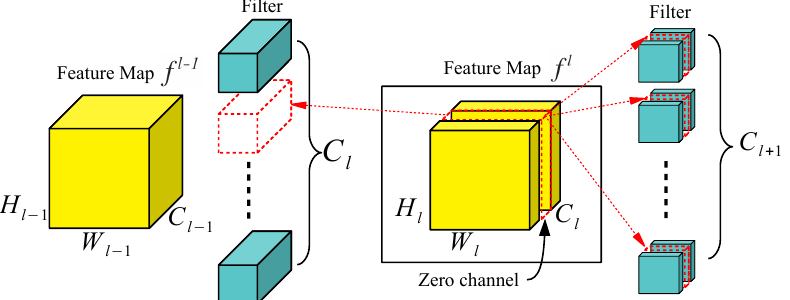
Figure 1. Removing filters based on the zero-response channel in the feature map: by removing the zero-response channel of the feature map f l , it is possible to reduce the filters of the encoder convolution layer that generates the zero-response and the filters of the decoder convolution layer that takes the zero-response as